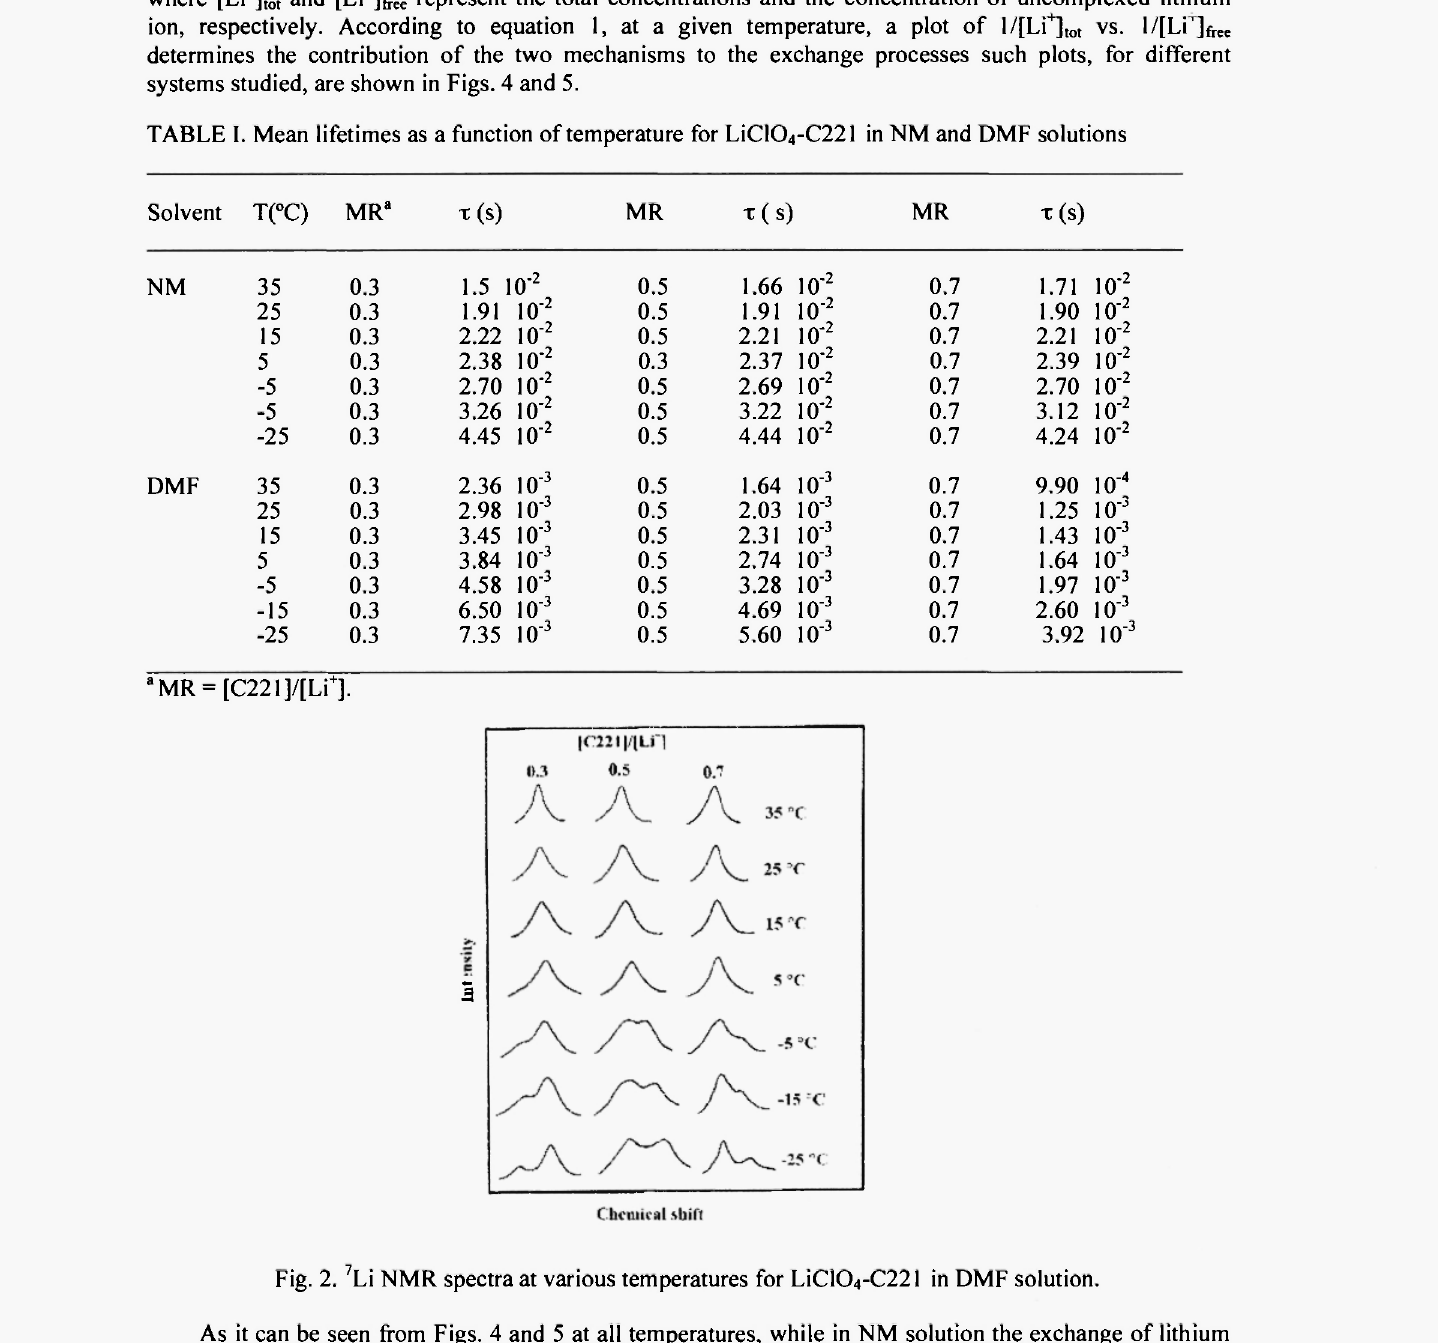
TABLE I. Mean lifetimes as a function of temperature for LiC10 4 -C221 in NM and DMF solutions